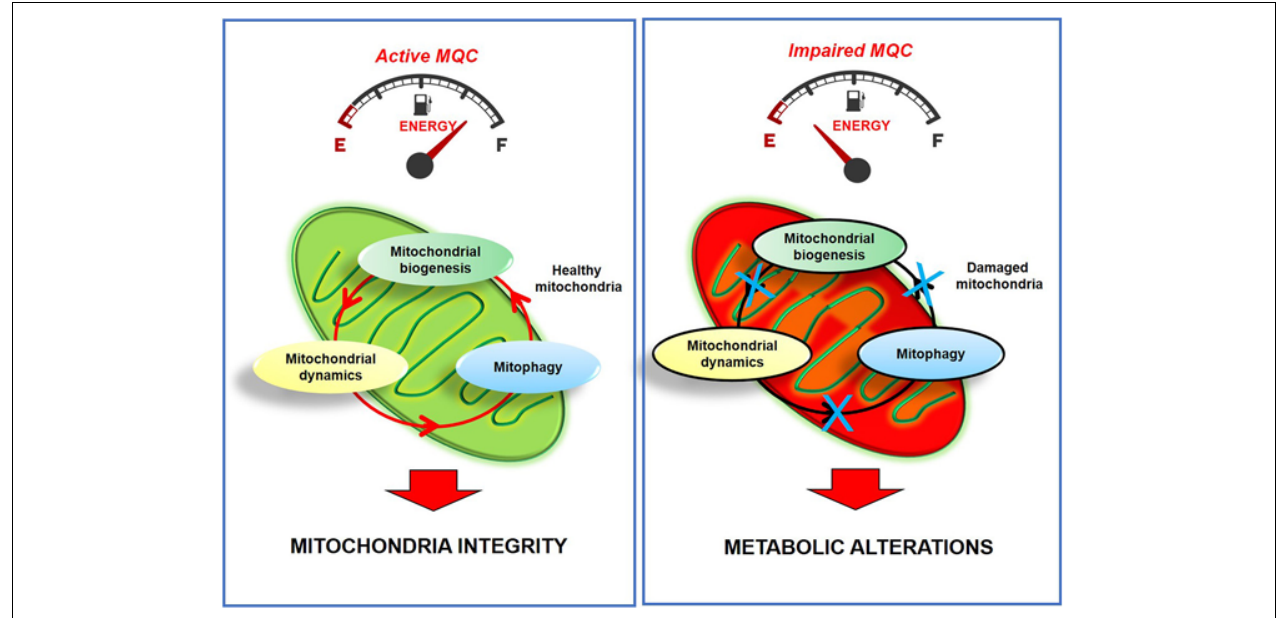
FIGURE 1 | Active MQC is essential for maintaining mitochondria integrity and function. The impairment of MQC leads to metabolic alterations and irreversible mitochondria